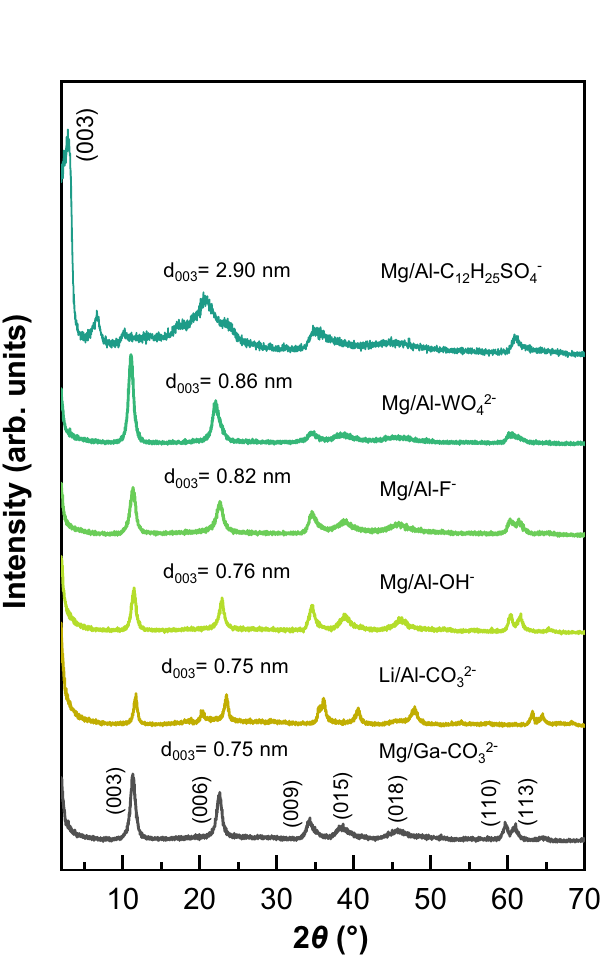
Fig. 9 | XRD patterns of regenerated LDHs. XRD patterns of LDHs with different anions or cations prepared with a solid-state recovery process from corresponding